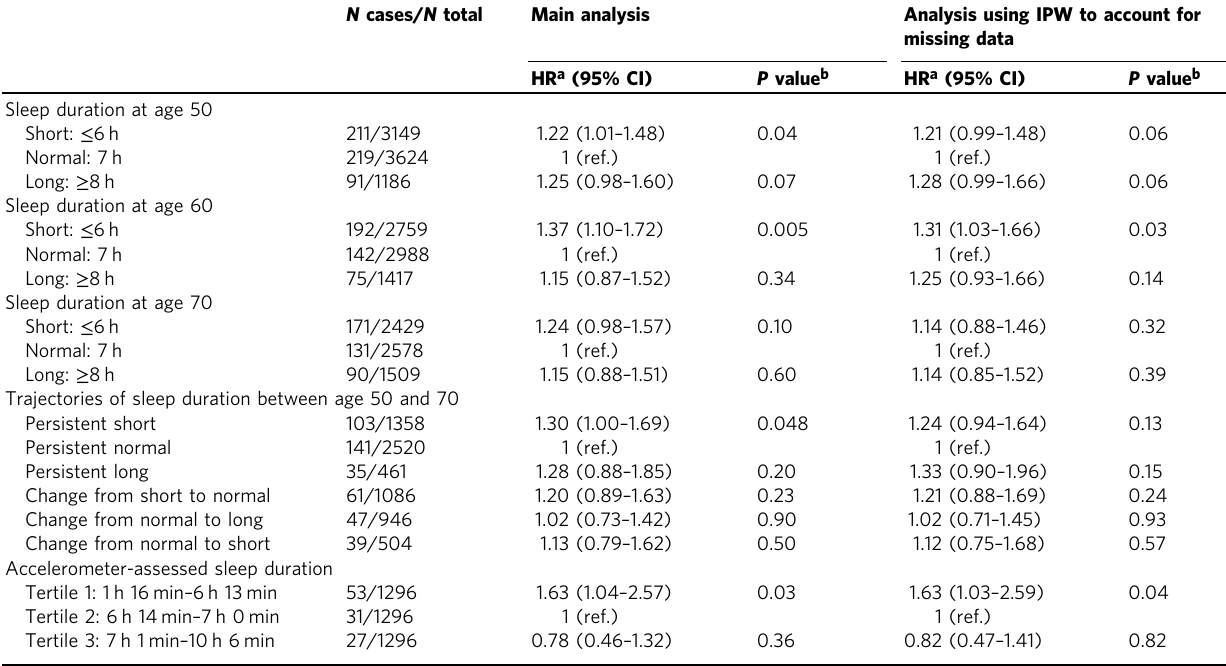
Table 7 Sensitivity analysis: use of inverse-probability weighting (IPW) to account for missing